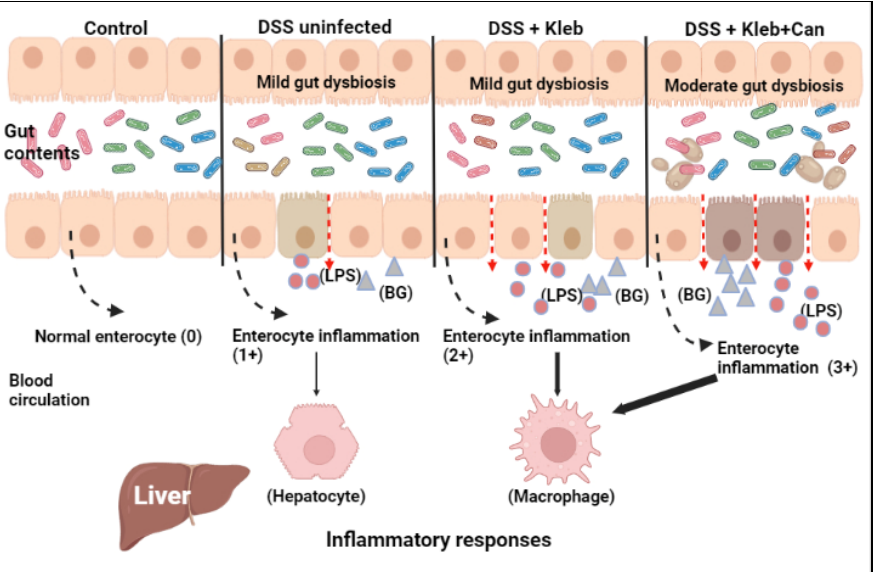
Figure 9. The proposed working hypothesis demonstrates the role of Candida with and without Klebsiella in dextran sulfate solution (DSS)-induced enterocyte injury. Dextran sulfate solution (DSS) with Klebsiella activates more enterocyte inflammation than DSS alone but is lower than the activation by DSS with Klebsiella plus Candida . The more prominent gut translocation of fungal plus bacterial molecules, as represented by lipopolysaccharide (LPS) and (1 → 3)- β -D-glucan (BG), in DSS with Klebsiella plus Candida -administered mice induces profound inflammation through the responses of hepatocytes and macrophages. Notably, the thickness of the solid arrows represents the